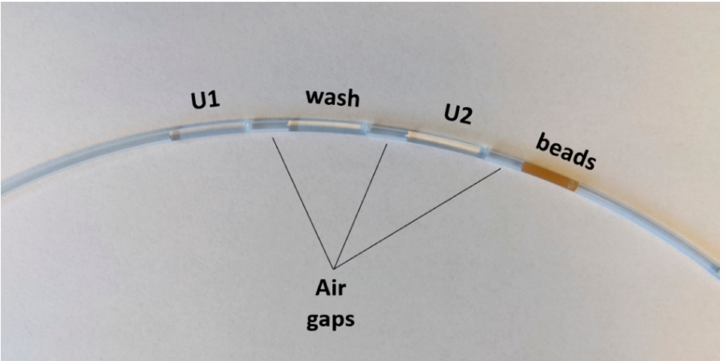
Figure 3. Picture of a pre-arrayed reaction cassette for use in the autoPiLOT reaction